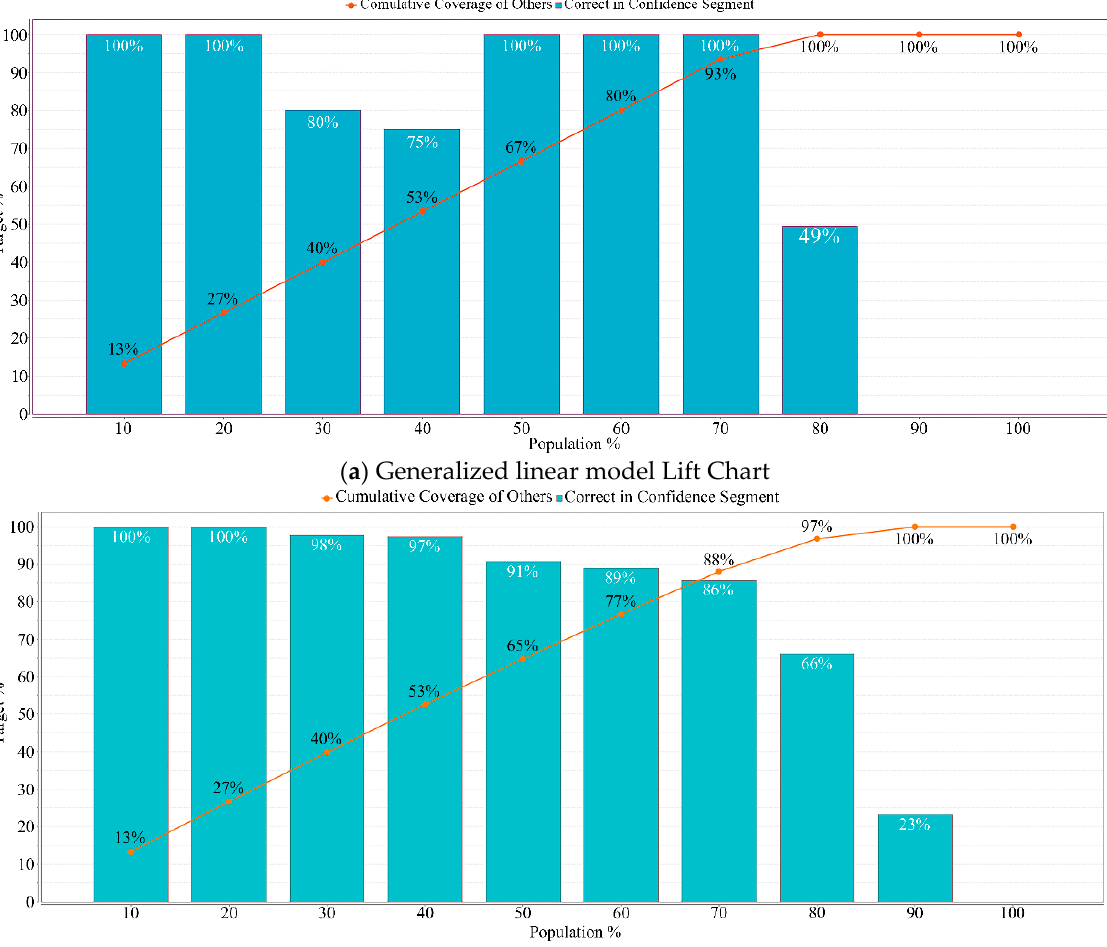
Figure 6. ( a – d ) Performance matrices for proposed machine-learning models.